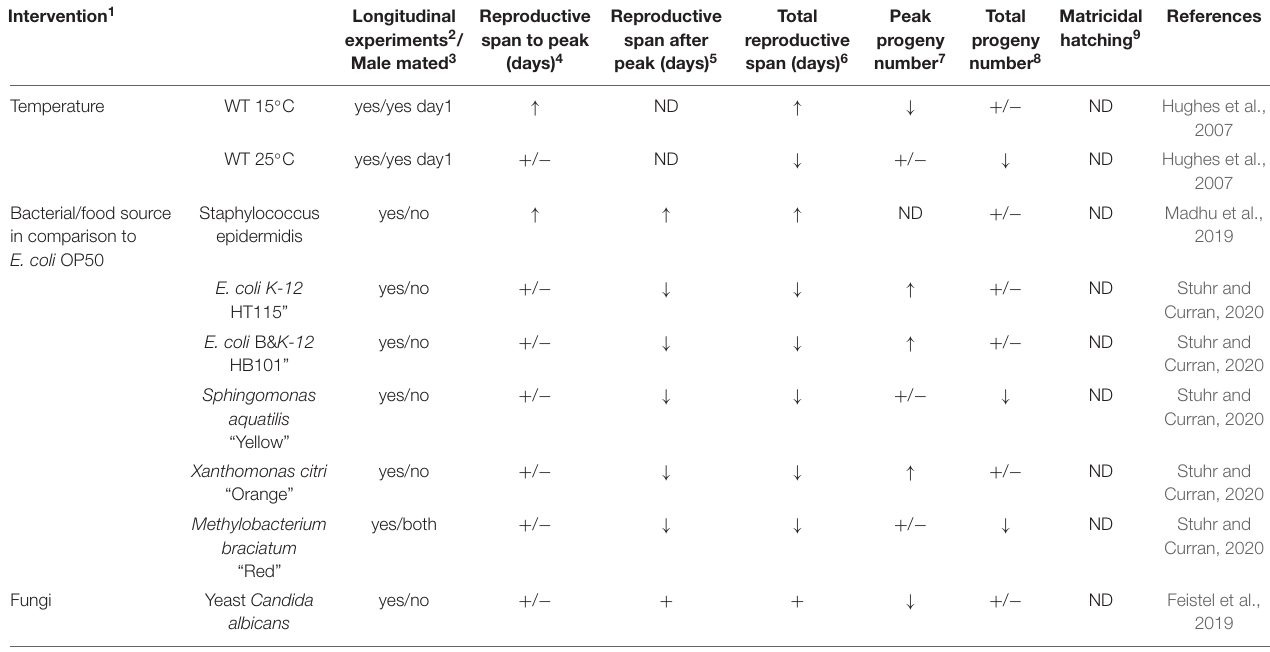
TABLE 2 | Environmental interventions that modulate reproductive aging in Caenorhabditis elegans